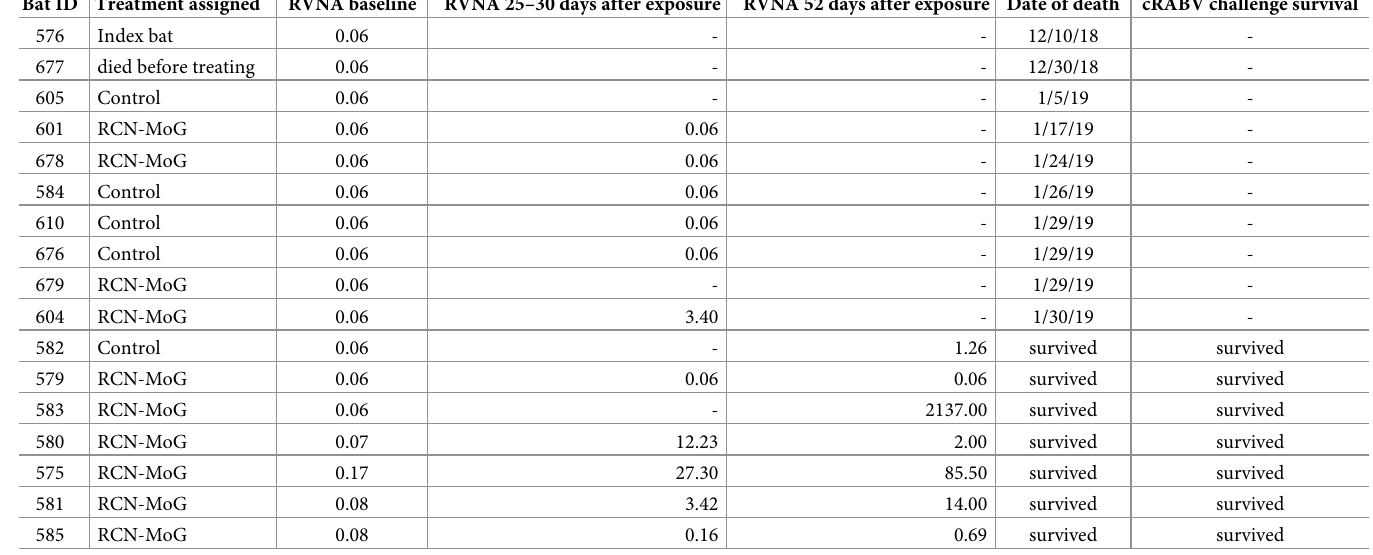
Table 2. Male vampire bats involved in the natural rabies outbreak, from Dec 10, 2018–Jan 30, 2019 (n = 17). All were housed together with the index case (bat #576). Bats were initially assigned to treatment groups based on the detection of RVNA at the baseline timepoint (obtained on Nov 2, 2018). A blood sample was obtained from most bats to determine RVNA titers approximately 25–30 days after the index bat died and in surviving bats 52 days after the index case. RVNA are expressed in IU/mL. Bats surviving the natural outbreak were challenged with cRABV on April 25, 2019, and only data from those bats are included in analyses for this study. Bat ID Treatment